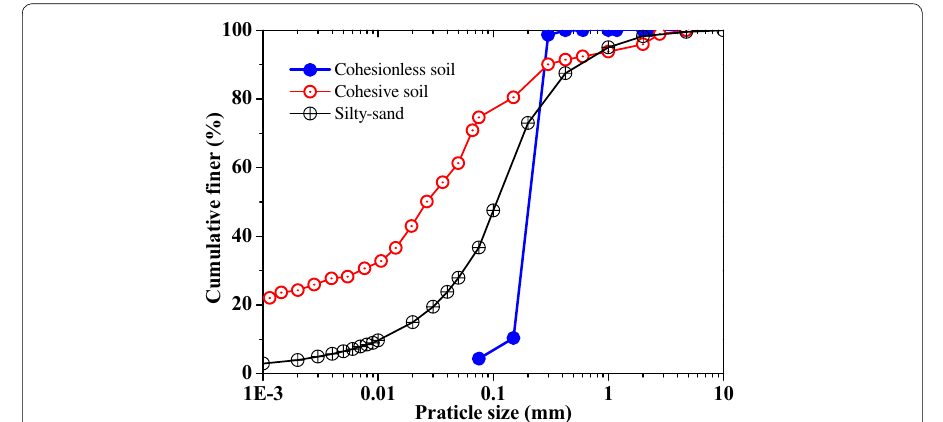
Fig. 4 Particle size distribution of the soils used in the present study